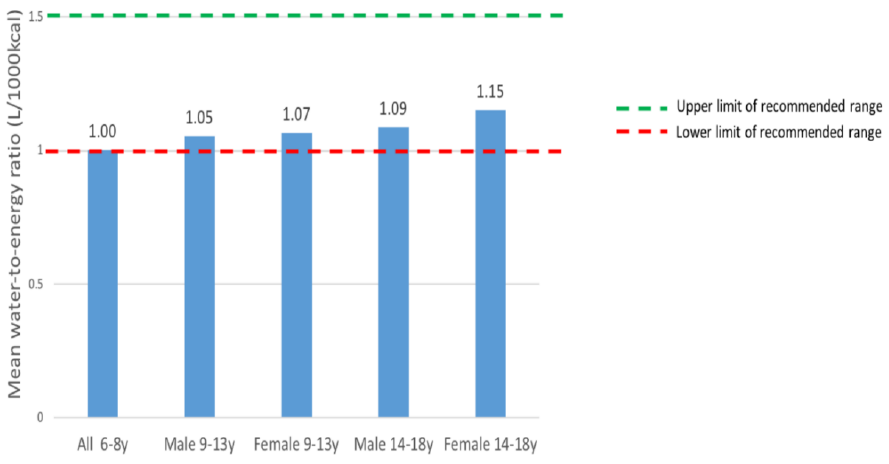
Figure 4. Mean water-to-energy ratio by age group and sex.